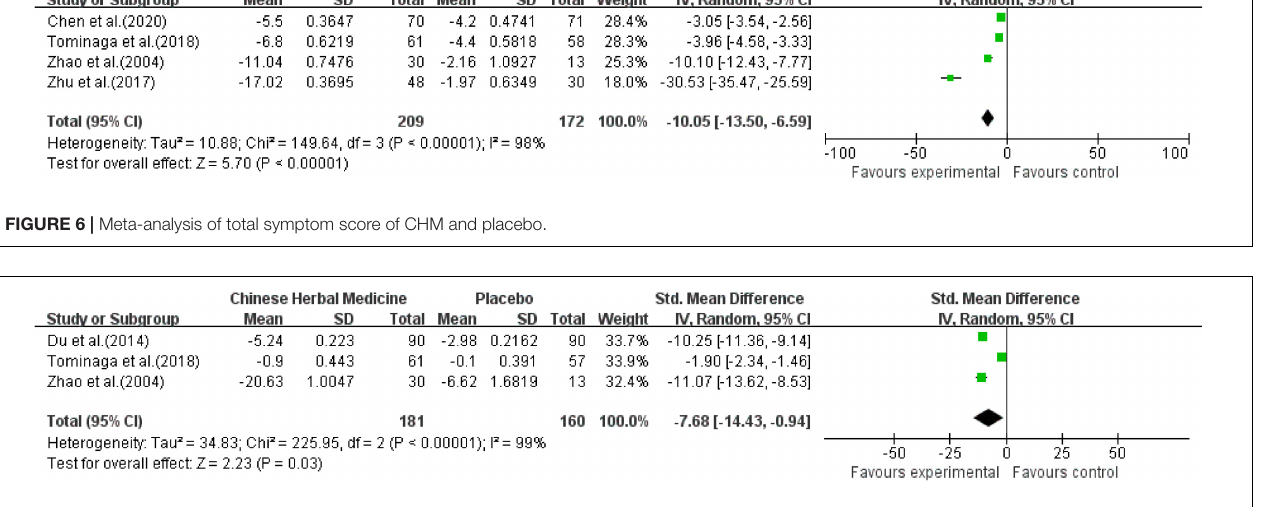
FIGURE 7 | Meta-analysis of depression score of CHM vs.